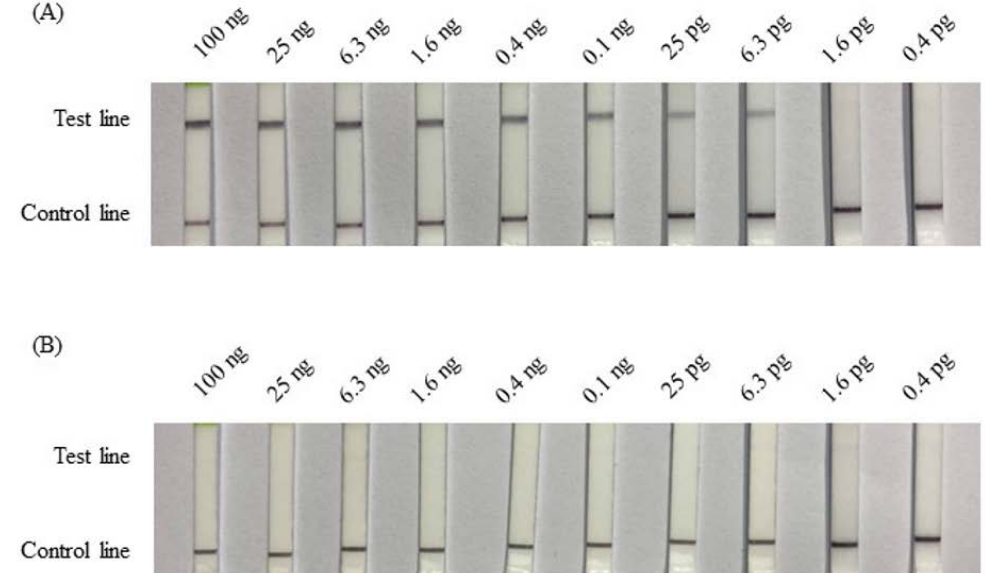
The sensitivity of the RPA-LFD assay was tested using 4-fold serial dilutions of total DNA at concentrations ranging from 100 ng to 0.4 pg, and was performed at 37 °C for 25 min. In the female samples (Figure 4A), the test lines appeared from 100 ng to 6.3 pg. No bands appeared when the total DNA was less than 1.6 pg. A detection limit of 6.3 pg total DNA was identified for female pigeon samples. In male samples (Figure 4B), no visible bands were detected for any amount of total DNA, ranging from 100 ng to 0.4 pg.